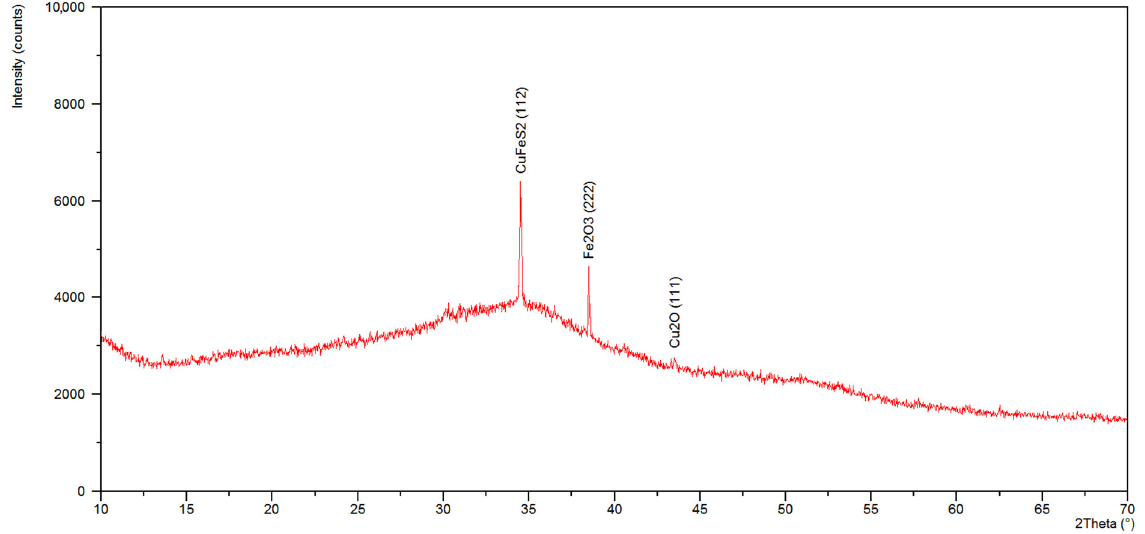
Figure 9. X-ray diffraction patterns of the control solution.